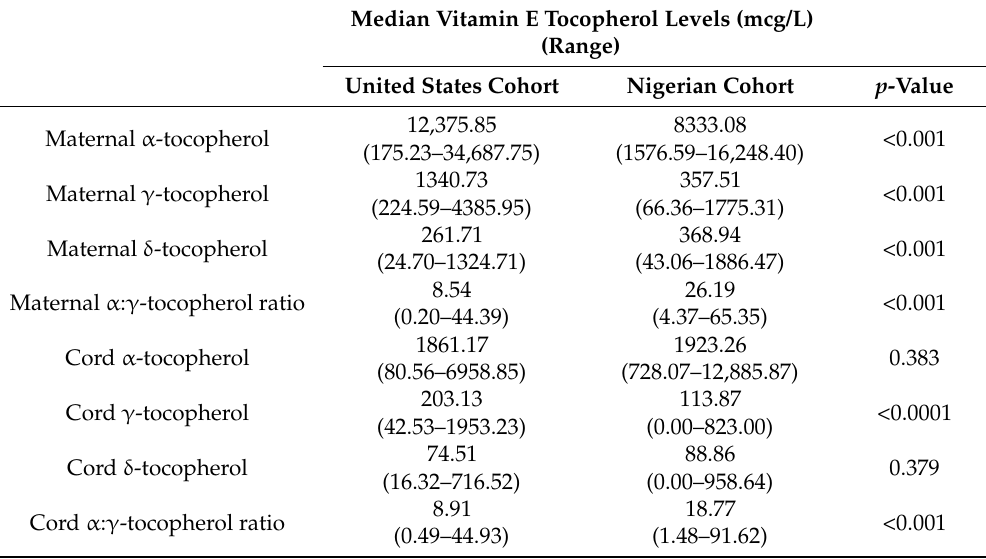
Table 2. Maternal and cord plasma tocopherol levels *. Median Vitamin E Tocopherol Levels (mcg/L)